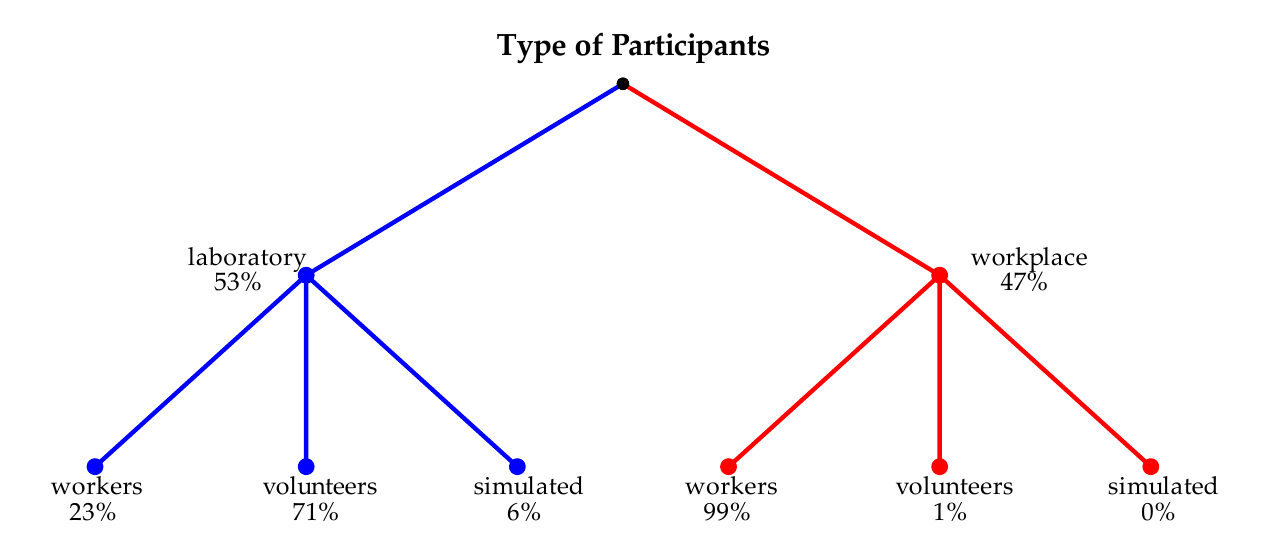
Figure 5. Distribution of selected papers based on the cohort of participants enrolled in the laboratory setting ( on the left ) and in the workplace setting ( on the right ). Participants were classified as workers, volunteers and simulated.